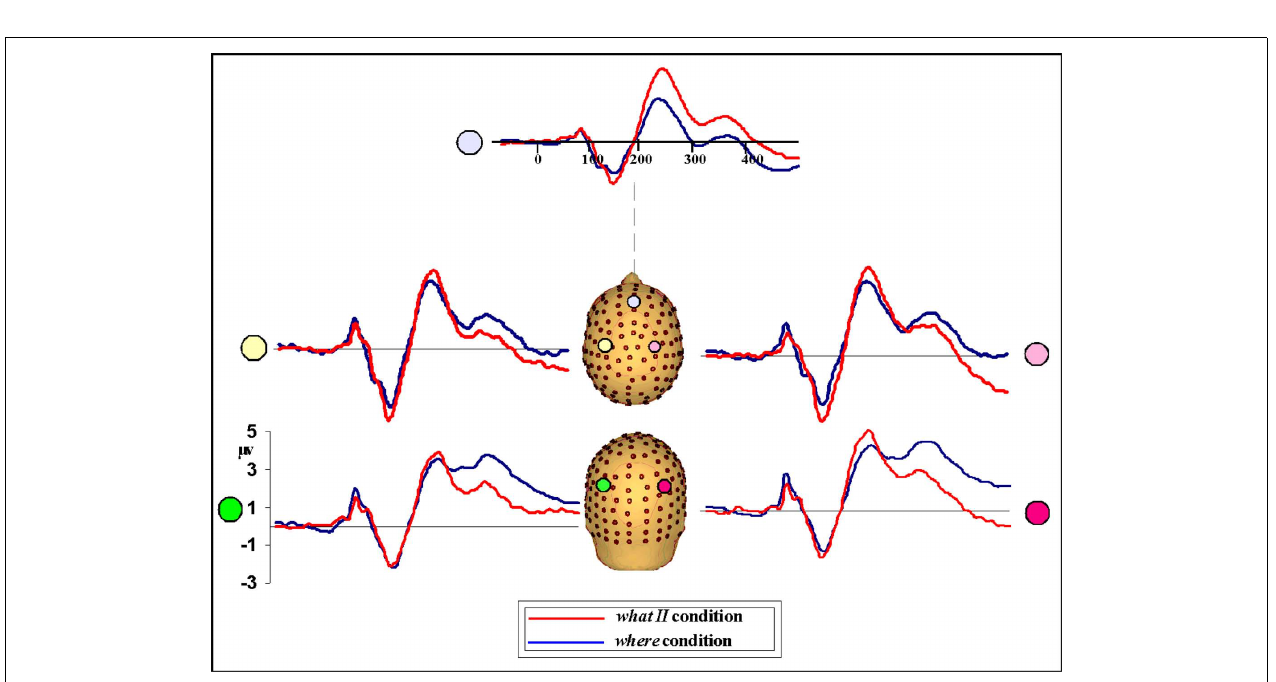
FIGURE 13 |Waveforms from participants ( n = 6) comparing performance in WHAT II and WHERE conditions. The direction of the N1 amplitude